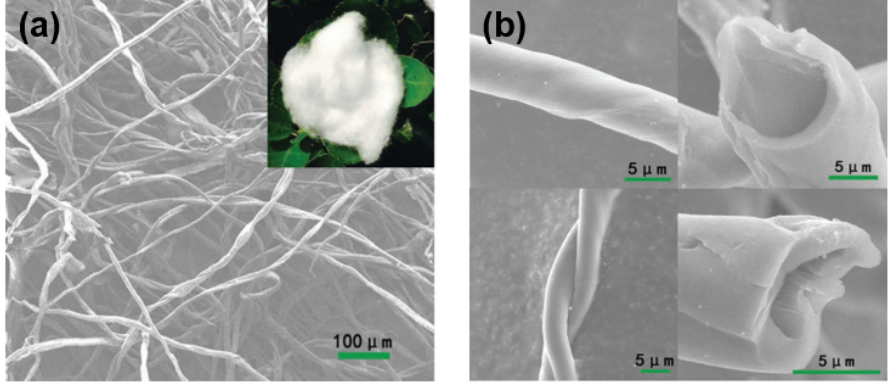
Figure 13. ( a ) SEM image of carbon source cotton. ( b ) The magnified SEM images of the carbonized cotton with a clear and visible hollow structure [49].